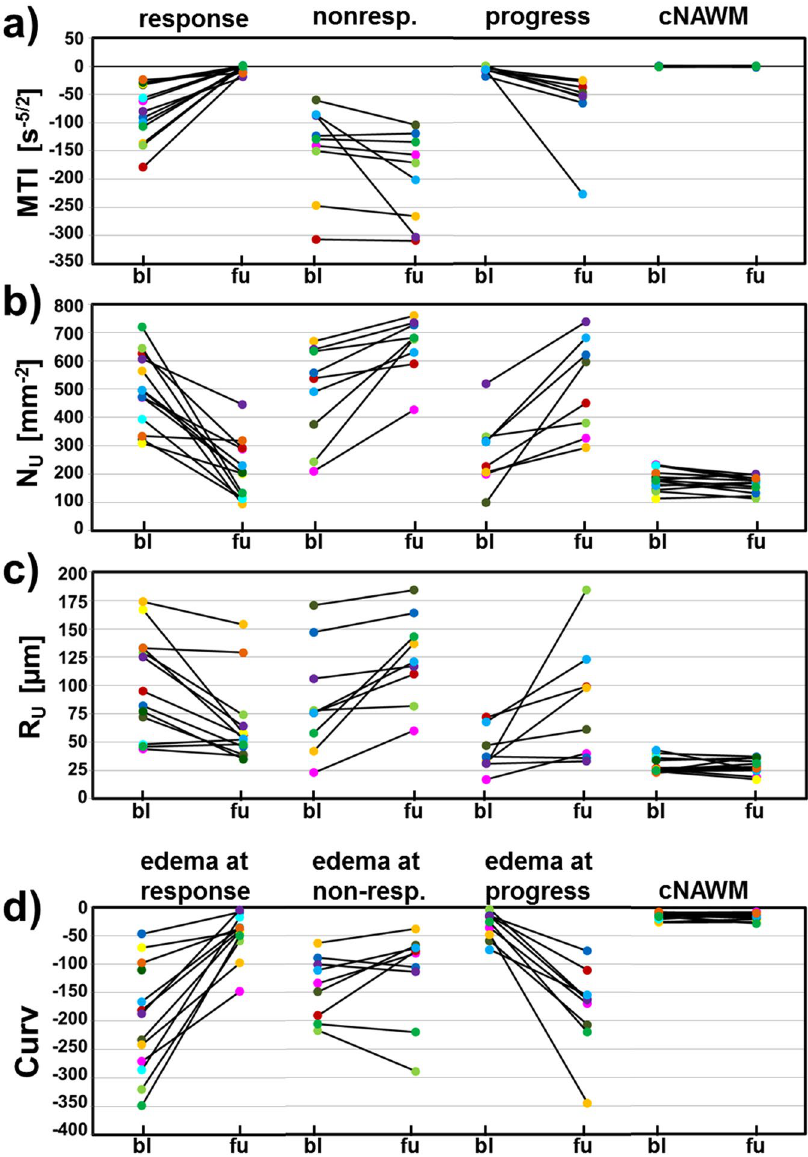
Figure 5. Changes for the ( a ) MTI, ( b ) N U , and ( c ) R U for each patient individually in responding (all 13 patients), non-responding (9 patients) tumor, and in tumor progression (8 patients). ( d ) Shows the changes of the Curv parameter in peritumoral edema associated with the tumor areas in ( a – c ): edema in the vicinity of responding tumor, non-responding tumor, and tumor progression, respectively. Note: bl = baseline; fu = 3-month